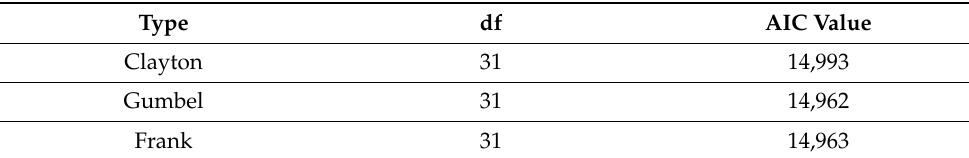
Table 3. The AIC results of the copula selection.